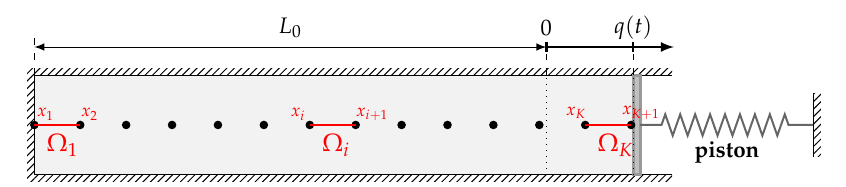
Figure 6. One-dimensional piston problem.